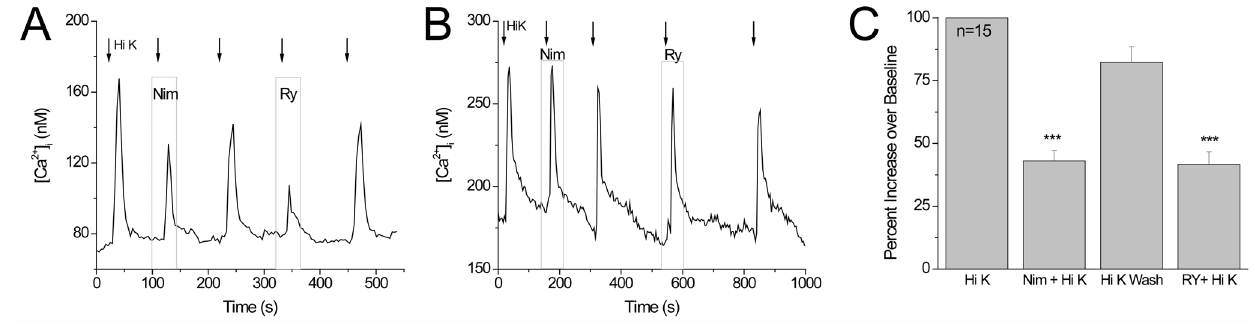
Figure 4. Ryanodine receptors are always found in the Type III taste cells that express L type voltage-gated calcium channels. A) Representative trace showing the inhibition of the calcium influx by nimodipine (10 m M) and ryanodine (20 m M) in the same cell. B) Representative trace showing the lack of RyRs in a cell with no L type channels. C) Pooled results showing the average inhibition by nimodipine and 20 m M ryanodine in the same mouse taste cells (***p , 0.001, n=15).